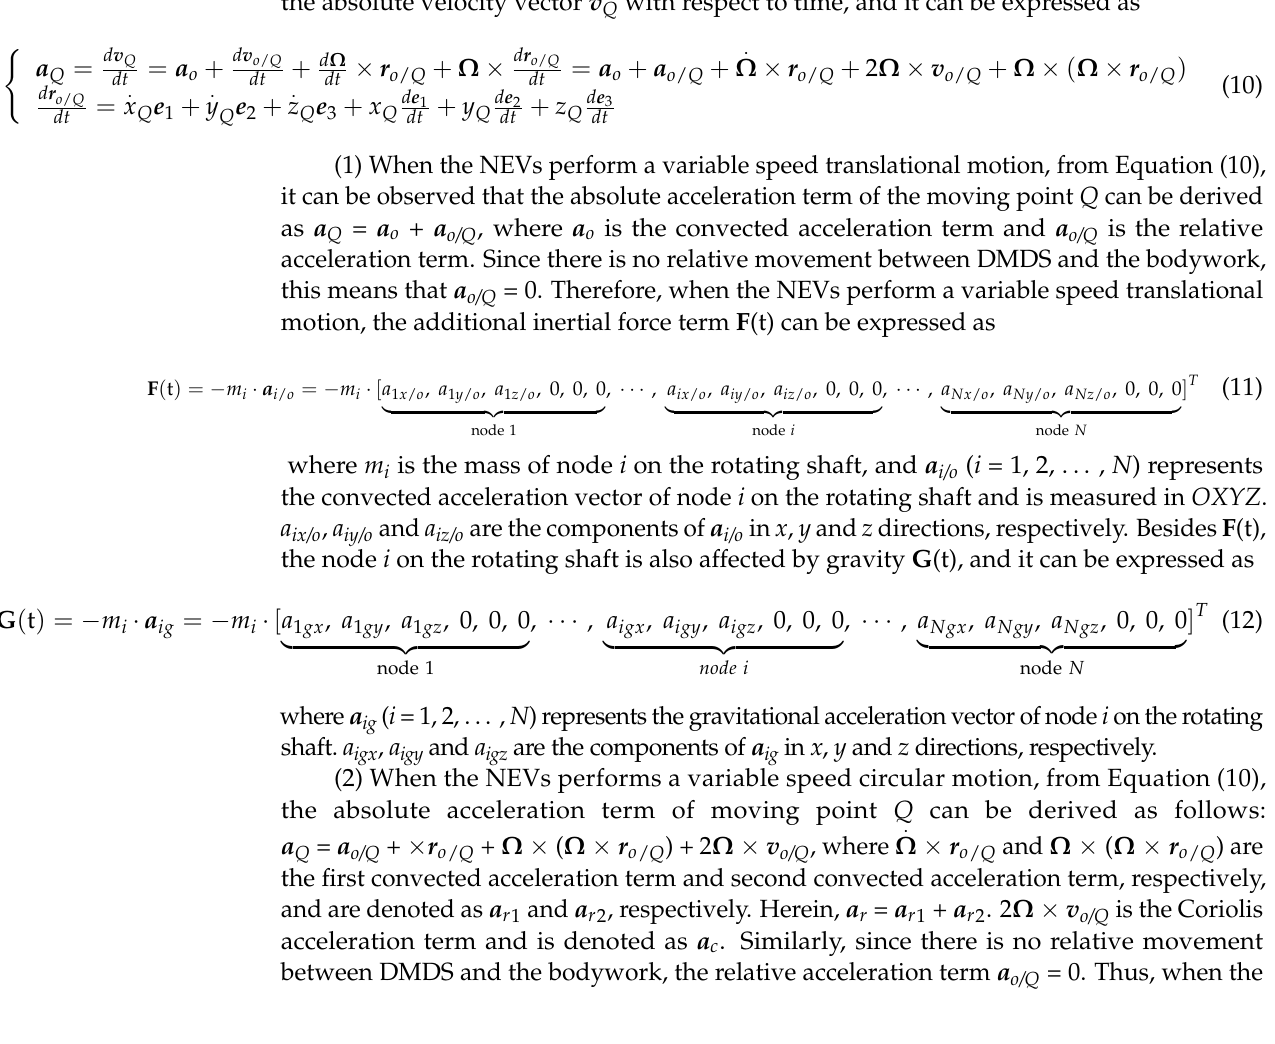
Figure 8. ( a ) Kinematic analysis in non-inertial system; ( b ) analysis of additional gyroscopic moment. Then, the absolute acceleration vector a Q can be obtained by taking the derivative of the absolute velocity vector v Q with respect to time, and it can be expressed